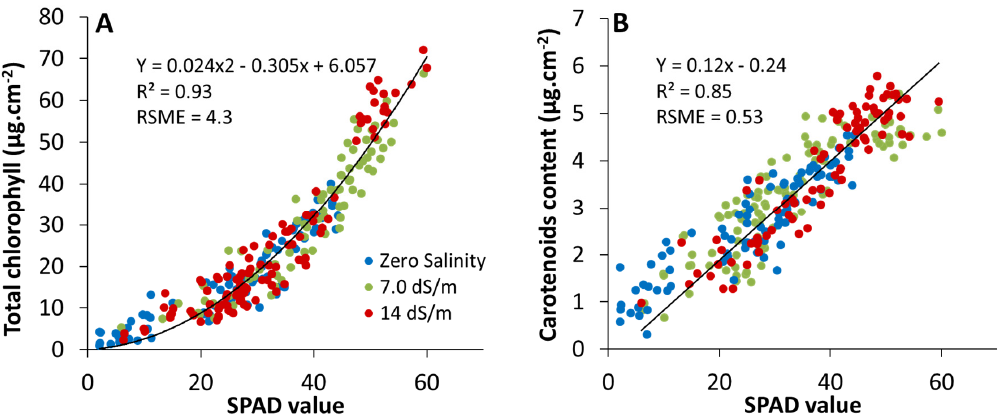
Figure 4. Relationships between SPAD ‐ 502 readings and the pigments at various levels of salinity and fertilizer application: ( A ) SPAD ‐ 502 vs. total chlorophyll content, and ( B ) SPAD ‐ 502 vs. total carotenoids content. Second ‐ order polynomial curve was fitted to the data of total chlorophyll content, whereas a linear curve was fitted to the carotenoids data ( n = 277 in each case).